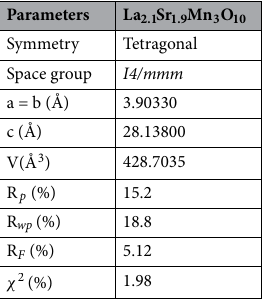
Table 1. The Rietveld refinement parameters of